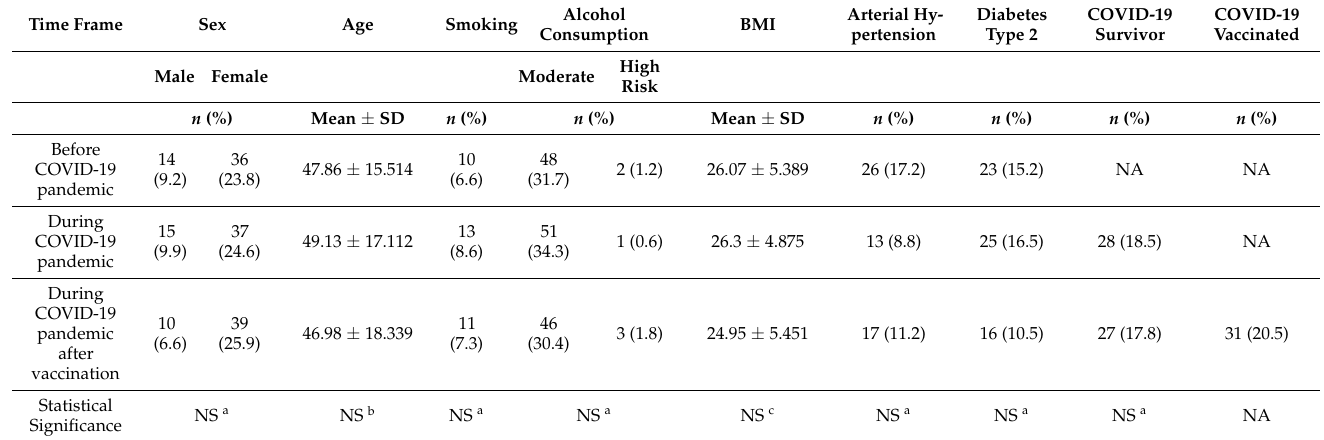
Table 2. Demographic and clinical characteristics of the study